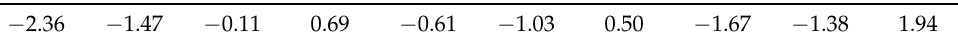
Table A3. Hidden neurons bias values (10 hidden neurons).